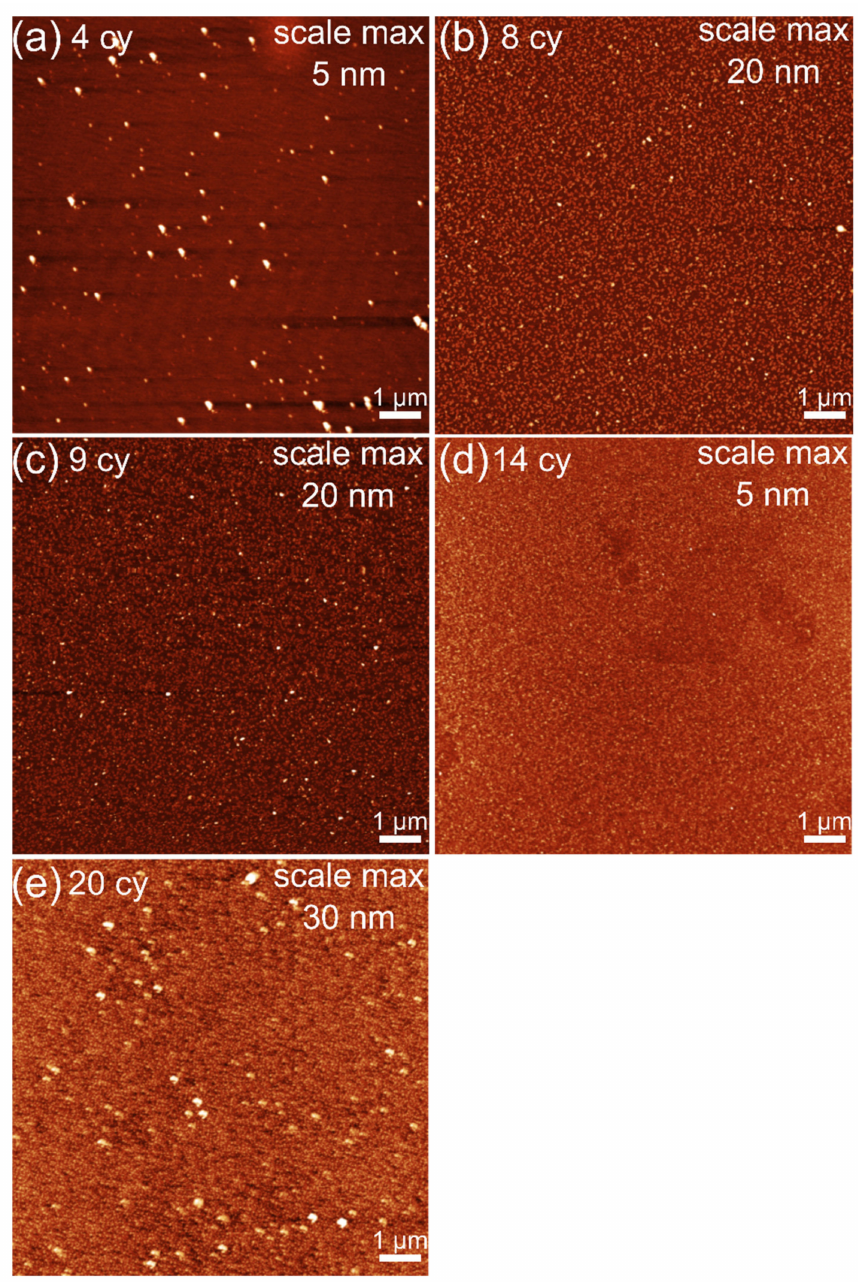
Figure 5. AFM height images of ZnO on Si substrates grown at room temperature with ( a ) 4, ( b ) 8, ( c ) 9, ( d ) 14, and ( e ) 20 PE-ALD cycles. Image size is 10 × 10 µ m for all images and the color bar maximum (white) is indicated in the